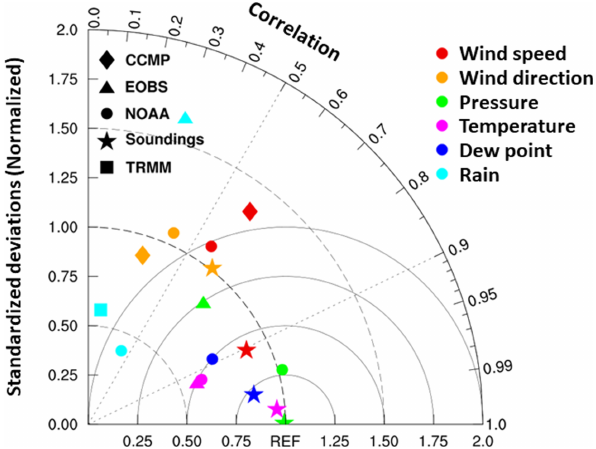
Figure 3. Taylor diagram summarising the overall skills of the AdriSC WRF 3km model to reproduce wind speed and direction, sea-level pressure, temperature, dew point and rain compared to freely available observations including the E-OBS gridded dataset, the CCMP and TRMM remote-sensing gridded products, and the NOAA ground-based stations and UWYO soundings in situ mea-